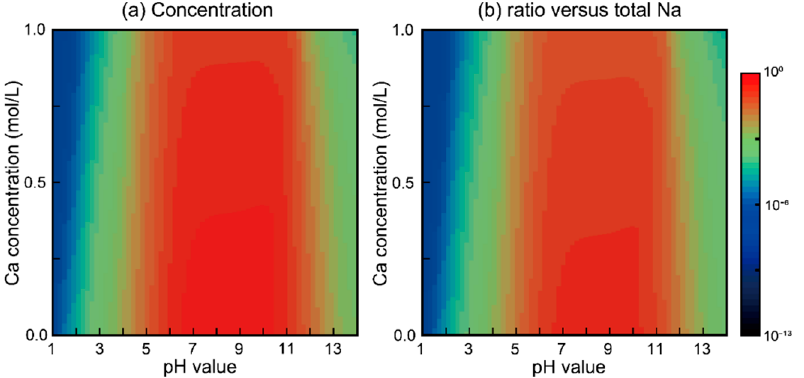
Figure 4. Calculated concentrations ( a ) and ratios ( b ) versus the total Na of NaHPO 4 − as a function of CaCl 2 concentration in solutions of 1 mol/L PO 4 and 2.0 mol/L Na + at 60 °C. of CaCl 2 concentration in solutions of 1 mol/L PO 4 and 2.0 mol/L Na